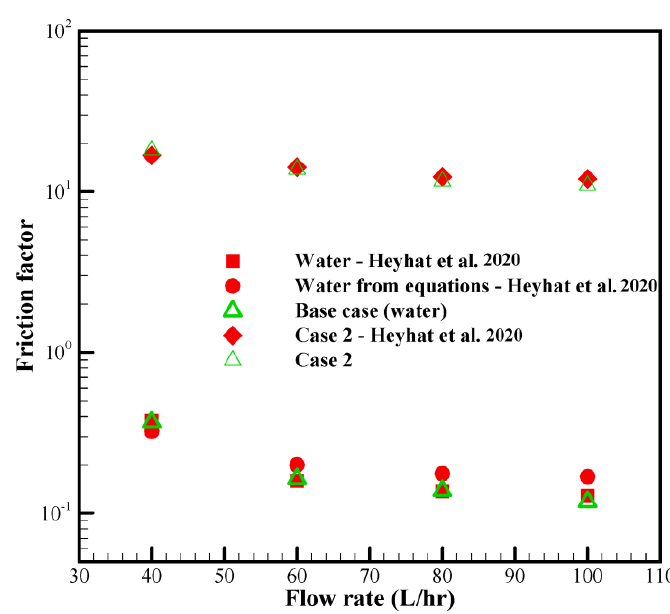
Figure 6. Comparison between the results of this study and results presented by Heyhat et al. [9].